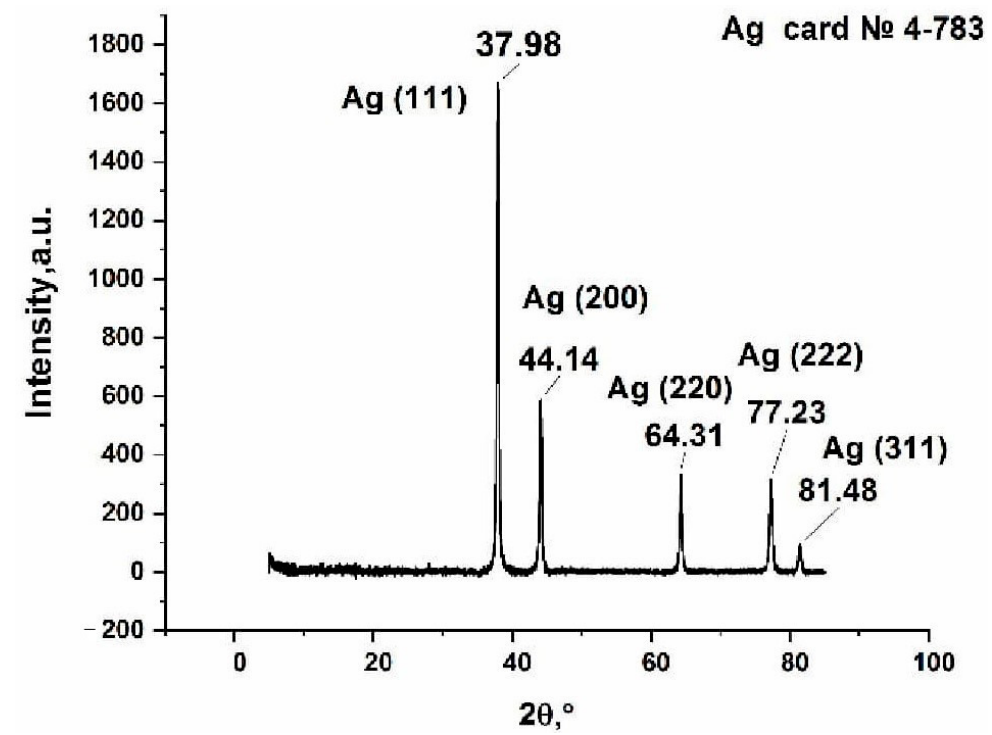
Figure 10. X-ray diffraction pattern of the thermolysis product of silver maleate. The product of the solid-state thermolysis of silver maleate was studied using TEM (Figure 11a). The TEM image visualizes spherical silver particles located in the stroma of the carbon material. The particle size of silver is between 2 and 32 nm. The particle distribution histogram is shown in Figure 11b.